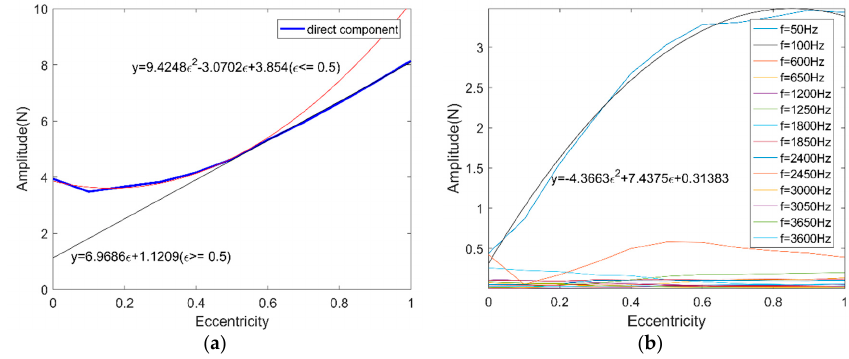
Figure 8. Frequency component variation of the spectrum of the UMF. ( a ) Direct component; ( b ) other frequency components.